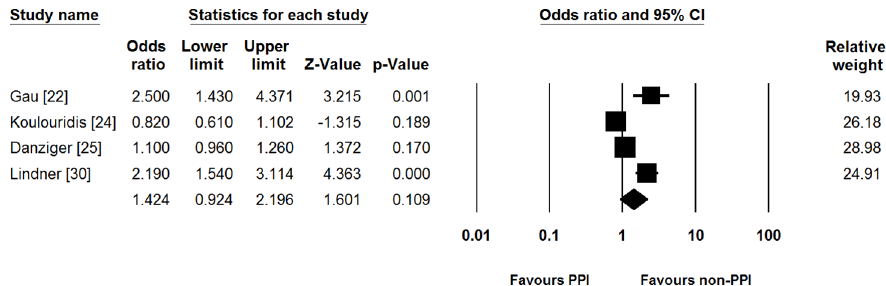
Figure 3. Subgroup analysis for studies which included only hospitalized patients. PPI, proton pump inhibitor; CI, confidence interval.